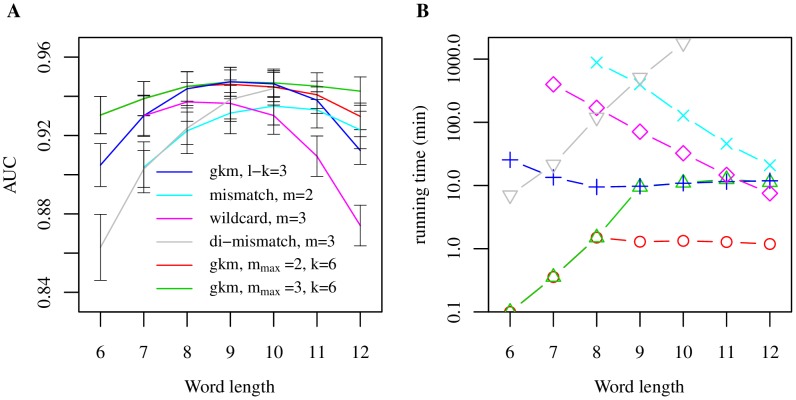
Comparison of gkm-SVM and existing methods on the mouse forebrain EP300 data set.(A) For each method, averages of 5-CV AUCs are shown as a function of the word length with the optimal number of mismatches, m, held fixed. Also shown are gkm-SVM results using fixed k = 6 and varying m
max. (B) Running time for each of the kernel computations shown in (A). Gkm-kernels show better classification performance and significantly more efficient computation at peak AUC.